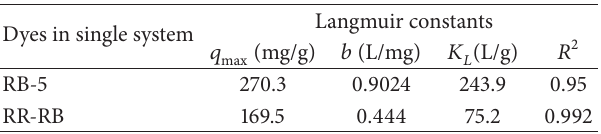
Table 3: Langmuir isotherm constants for RB-5 and RR-RB on QKCF in single